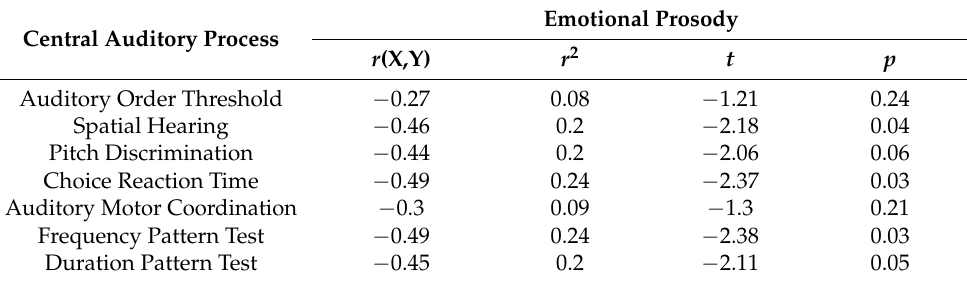
Table 4. Auditory low-level function and emotional prosody. Central Auditory